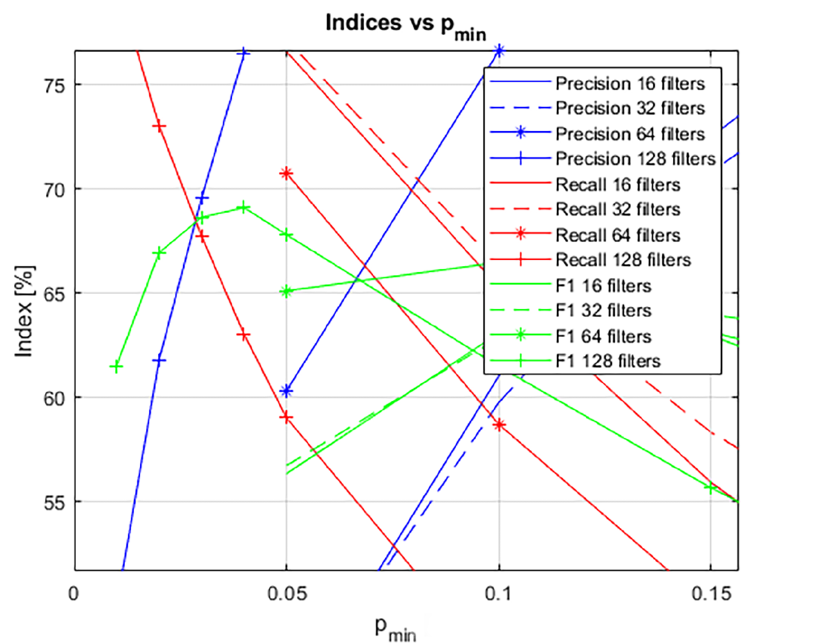
Figure 6. Details of performance curves vs. p min and